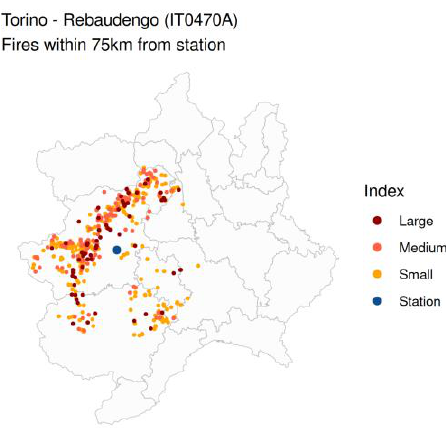
Figure 6. Piedmont region: description of wildfires, within a 75 km buffer around the air quality monitoring station, classified by categorial index.